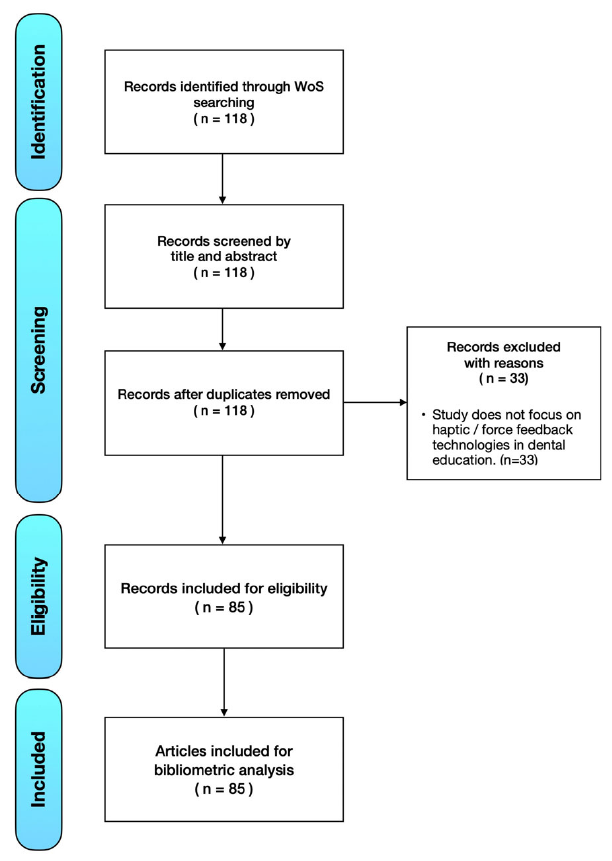
Figure 1. The PRISMA selective strategy flow diagram.